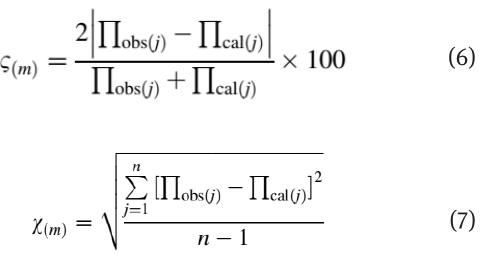
Figure 9: Influence of uniaxial compressive strength ( s c ) on elastic modulus (E) and the value of M R for all studied samples